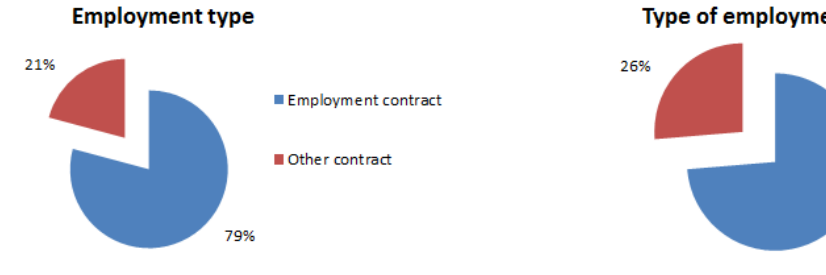
Figure 11 - Types of employment in the field of